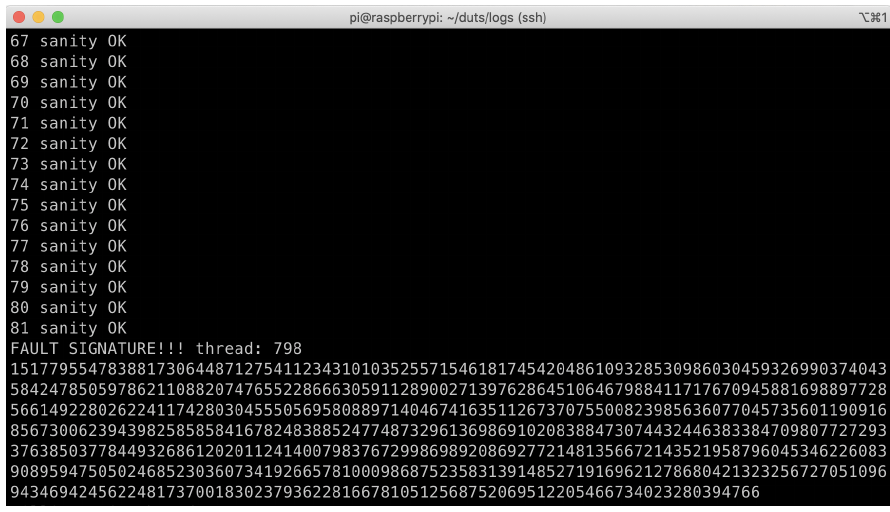
Figure 3. Output of the Raspberry Pi while running a repetitive RSA-CRT-Sign operation from the PyCrypto library. For testing purposes, the program prints every second a “sanity” message indicating the device is still alive and has not